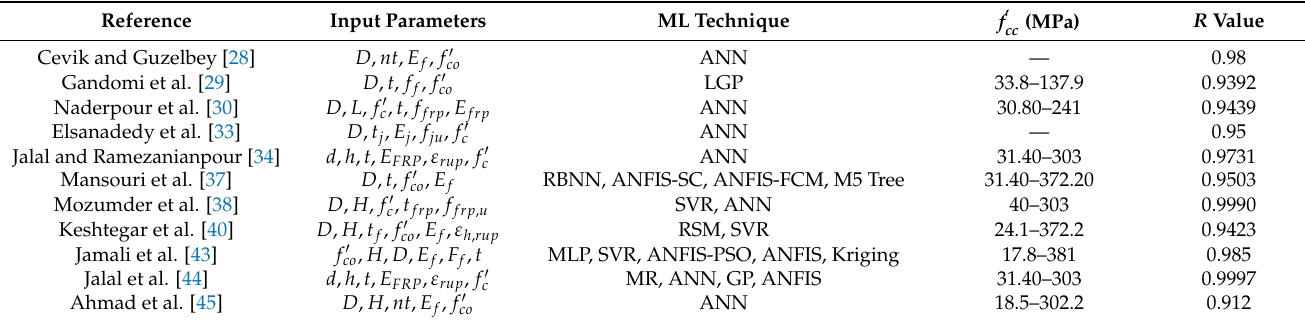
Table 1. Details of developed ML models to predict CS of FRP-confined concrete